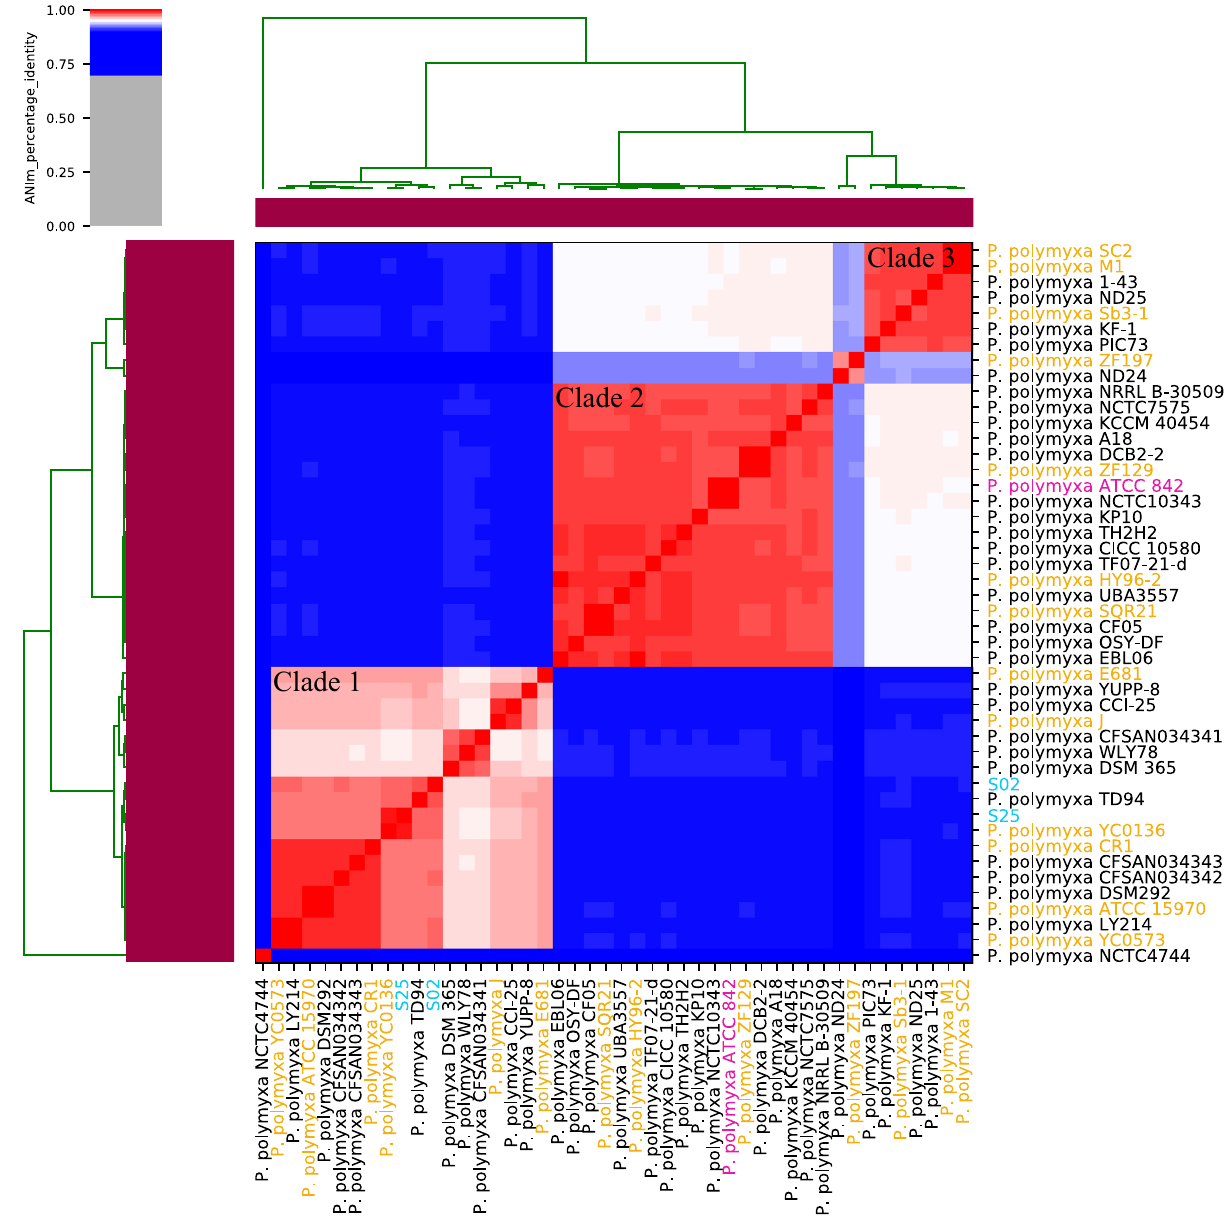
Figure 1. Phylogeny of Paenibacillus species based on a heatmap with row and column dendrograms from the average nucleotide identity (ANI) of genomes of Paenibacillus sp. strains S02 and S25 and 44 P. polymyxa strains from NCBI. Clustering across the dendrograms were based on overall genomic sequence similarity, forming three major clades and two minor clades (intra-cluster ANI > 95%). Clade 1 contained Paenibacillus sp. strains S02 and S25 as well as 16 known P. polymyxa strains. Clade 2 and 3 contained 18 and seven known P. polymyxa strains, respectively. P. polymyxa ZF197 and ND24 formed a minor clade, and P. polymyxa NCTC4744 formed another minor clade. Blue label: Paenibacillus sp. strains isolated in this study. Yellow label: P. polymyxa strains with complete circular genome sequences. Purple label: The type strain of P.